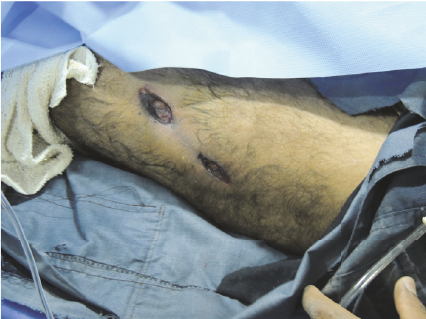
Figure 1: Longitudinal image of free fluid in the pelvis. Particulate matter is seen within the free fluid. The circular balloon of the urinary catheter can be seen on the right of the image.